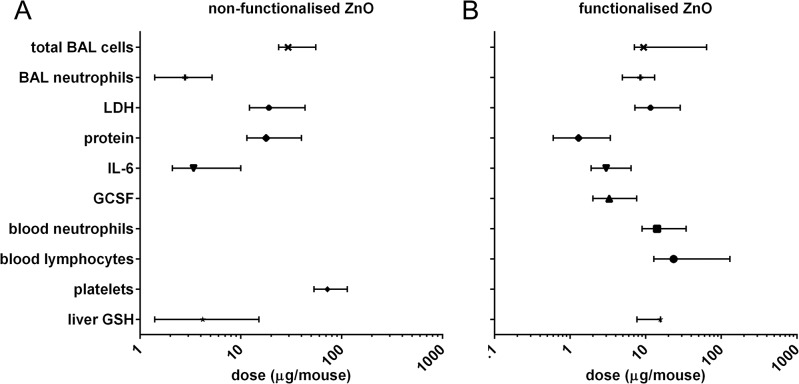
Summary of benchmark dose relationships.A) non-functionalised ZnO and B) functionalised ZnO (Log scale on the x-axis). BMDs including the confidence interval are plotted for those endpoints for which an effect was found.